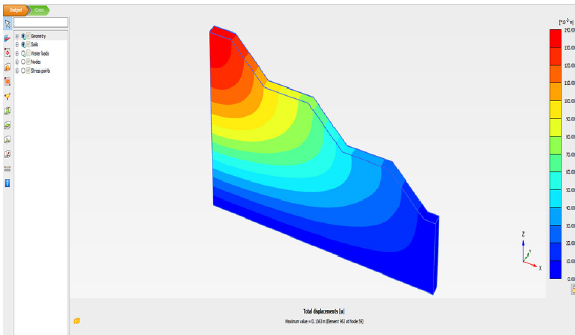
Figure 9. The vertical displacement of the embankment